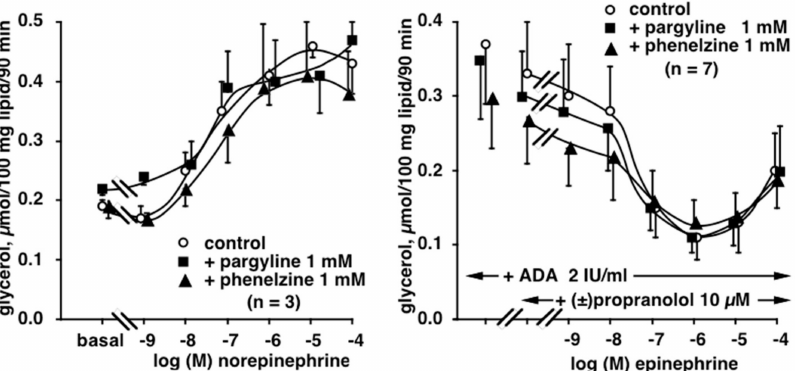
Figure 5. Lack of influence of monoamine oxidase (MAO) inhibitors pargyline and phenelzine on the norepinephrine and epinephrine e ff ects on lipolysis in human subcutaneous adipocytes. Left panel: dose–response curves of glycerol release were obtained with norepinephrine alone (control, open circles) or in the presence of pargyline (squares) or phenelzine (triangles) at 1 mM. Mean ± SEM of three adipocyte preparations. No significant di ff erence between control and 1 mM inhibitor. Right panel: biphasic action of epinephrine in the presence of propranolol and adenosine deaminase (ADA) in order to unmask the α 2-adrenergic antilipolytic component of the catecholamine (control, open circles). Mean ± SEM of seven adipocyte preparations. No significant di ff erence between control and 1 mM pargyline (squares) or phenelzine